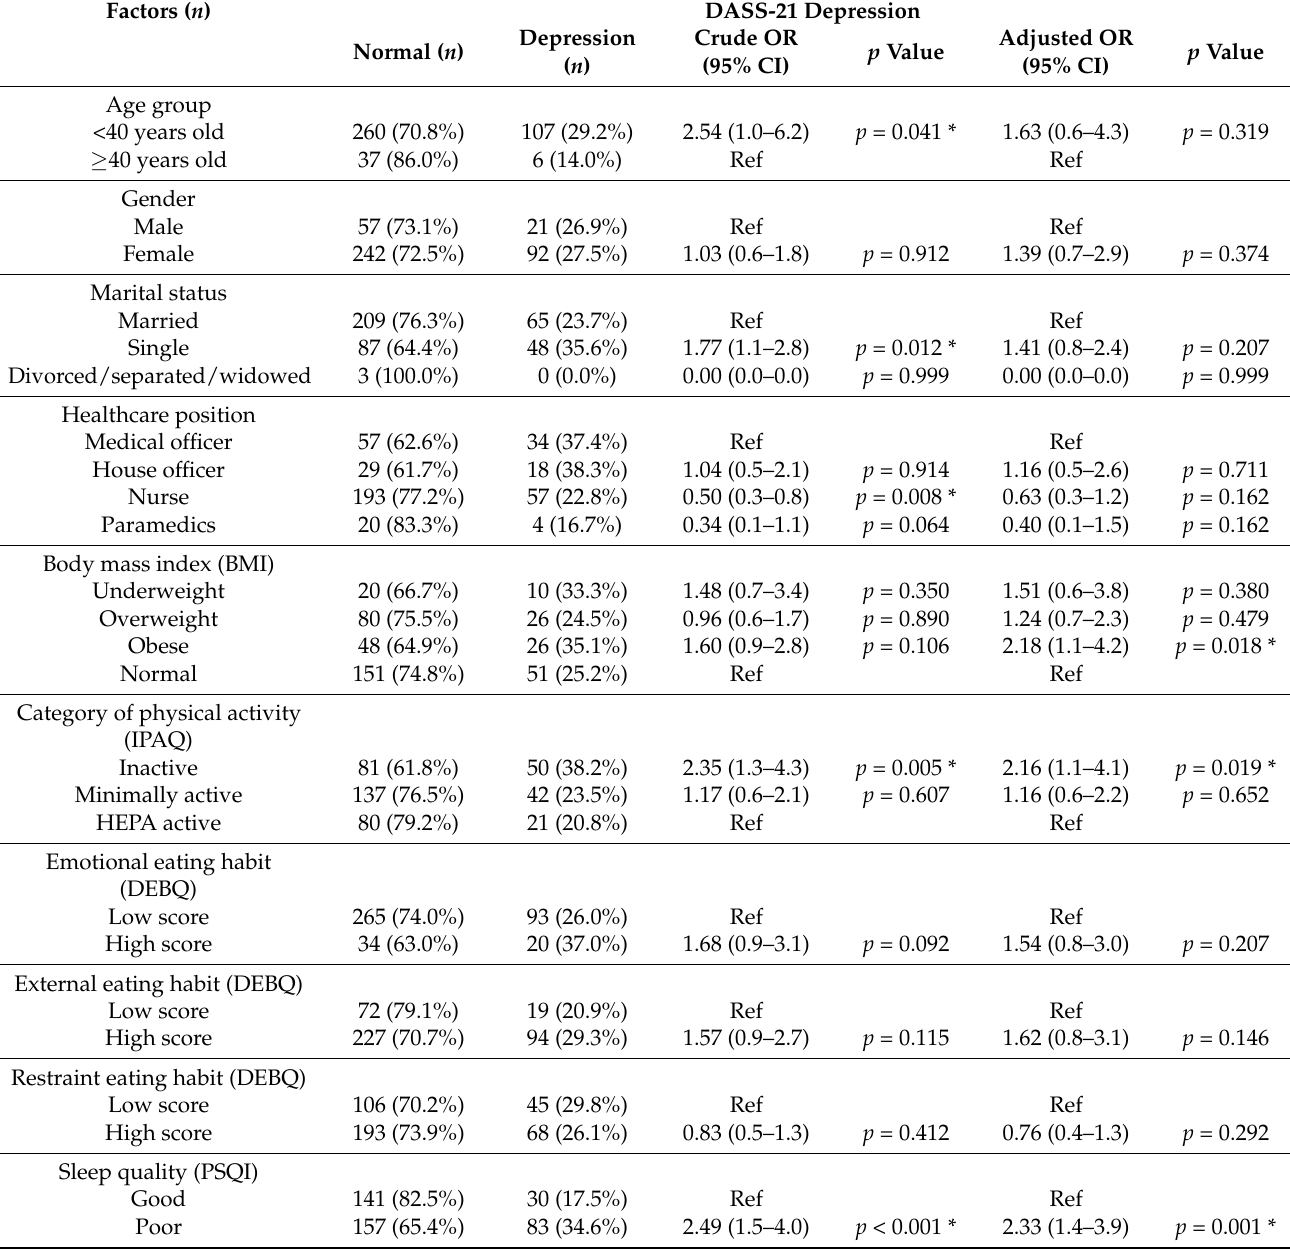
Table 3. The crude odds ratio (OR) and adjusted OR (AOR) for DASS-21 of